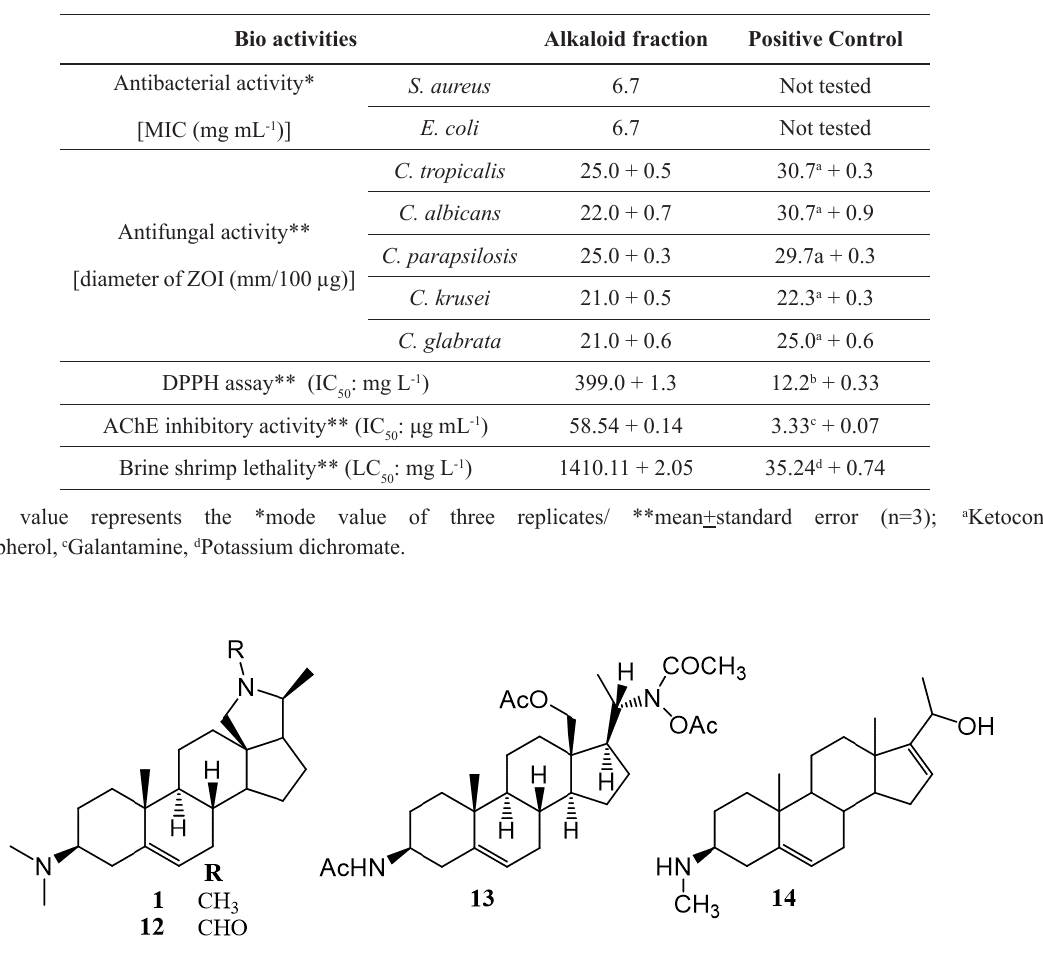
Table 1: Results of antibacterial, antifungal, antioxidant, AChE inhibitory activity activities and brine shrimp lethality of alkaloids extract of Holarrhena mitis .